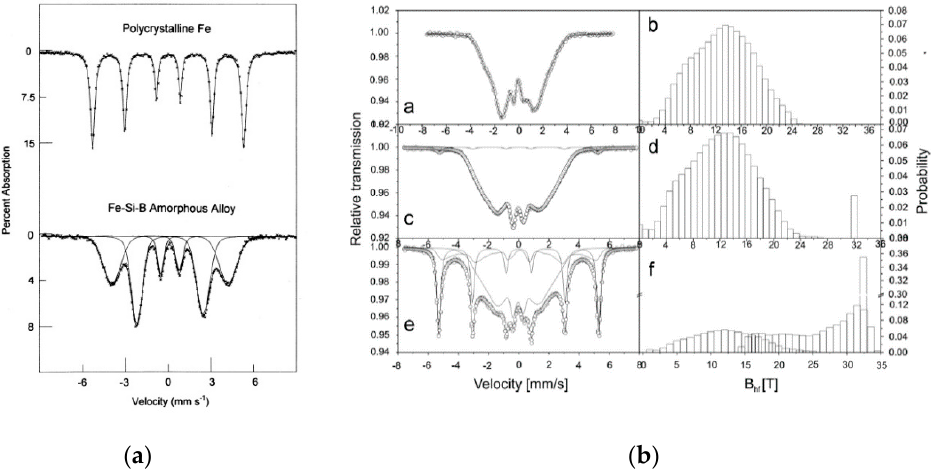
Figure 19. ( a ) Room temperature 57 Fe Mössbauer spectra of ribbons of polycrystalline α -Fe and the amorphous alloy Fe 78 Si 19 B 13 . Reproduced from [51]. ( b ) Transmission Mössbauer spectra (a,c,e) and corresponding hyperfine field distributions (b,d,f) for the Fe 81 Pt 5 Zr 7 Nb 1 Cu 1 B 5 alloy in the as quenched state ( a ) and after sequential annealing at 740 K for 15 min (c,d) and then at 780 K (e,f) for another 15 min. Reproduced from [54] with permission from Elsevier, 2014.